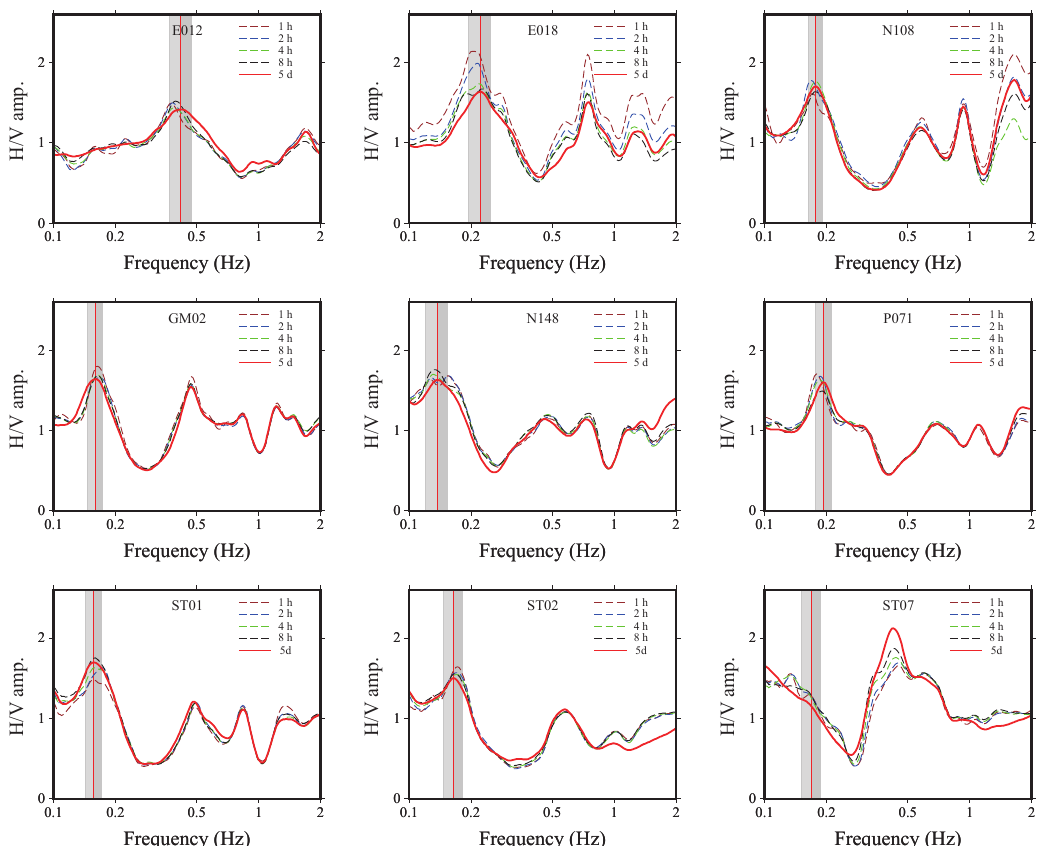
Figure 8. H / V spectra calculated using different lengths of ambient noise records. The vertical bars in all panels except for the last one represent the peak frequencies and the corresponding standard deviations the same as those in Fig. 3 and Fig. 6. There is a good consistency between H / V spectra determined with different testing length of noise records (1, 2, 4 and 8h) and the spectrum from the five day long record, both in locations of peak frequencies and the spectra shape. However, the peak frequency obtained from the 1h record deviates slightly the peak frequency determined using 5 day long record for the E012 station.